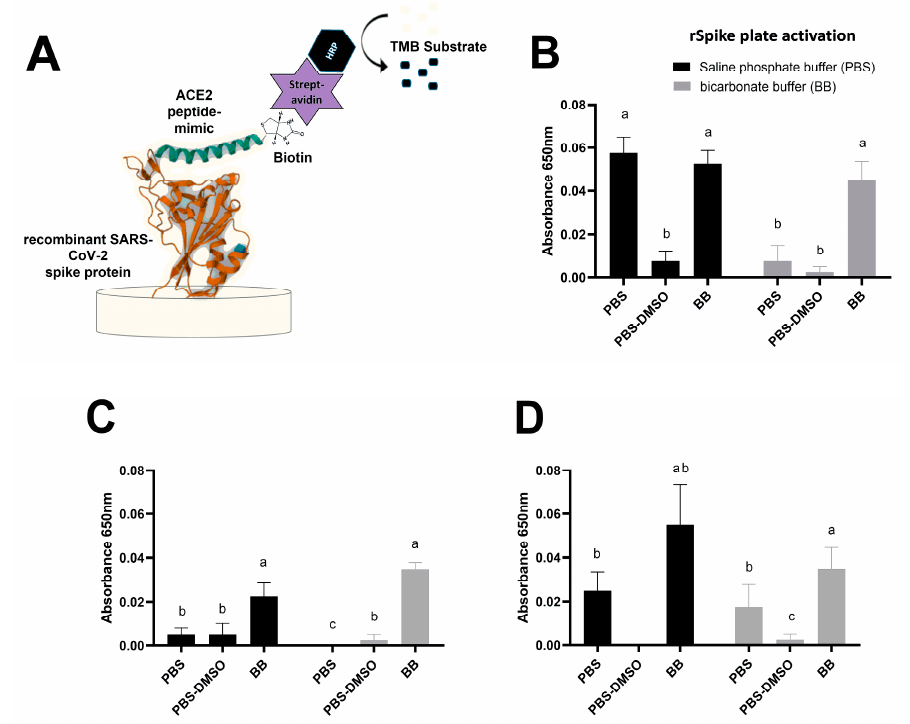
Figure 4. Measurement of rSpike-ACE2 peptide mimic interaction under different saline buffer conditions. ( A ) Schematic diagram of the bs-ELA experiment steps. ( B – D ) shows differences in the microplate activation with rSpike in PBS (black bar) or BB (grey bar) at 0.42 µ M, 0.38 µ M, and 0.21 µ M, respectively. Differences were considered significant when p < 0.05 and indicated with a different letter after one-way ANOVA.